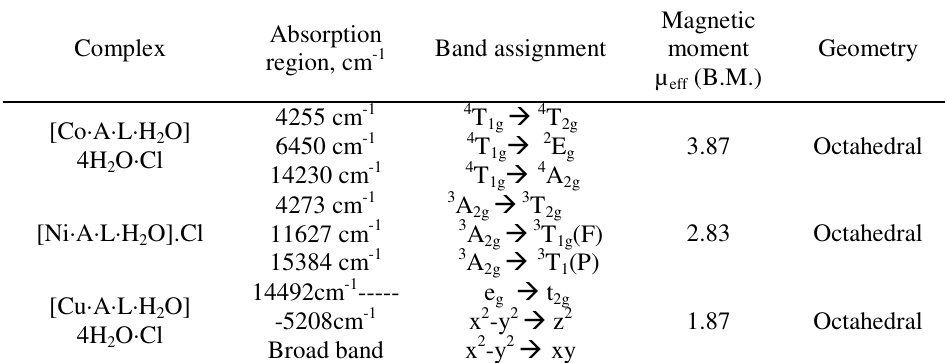
Band assignment